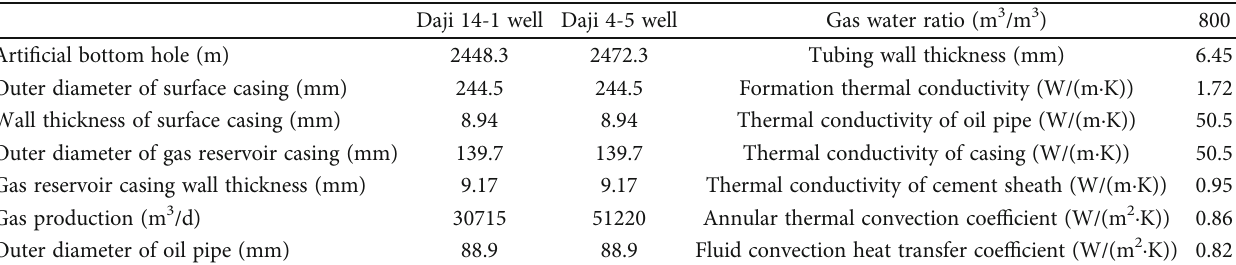
Table 1: Structural parameters of well Daji 14-1 and Daji